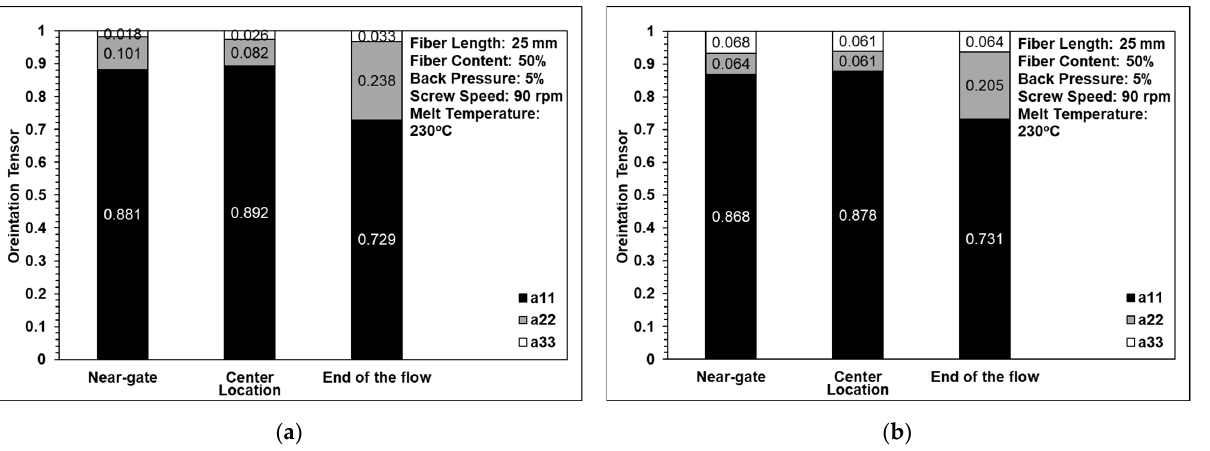
Figure 8. Comparison of orientation tensor in ( a ) computed tomography and ( b ) optical microscopy images of a single-edge gate.